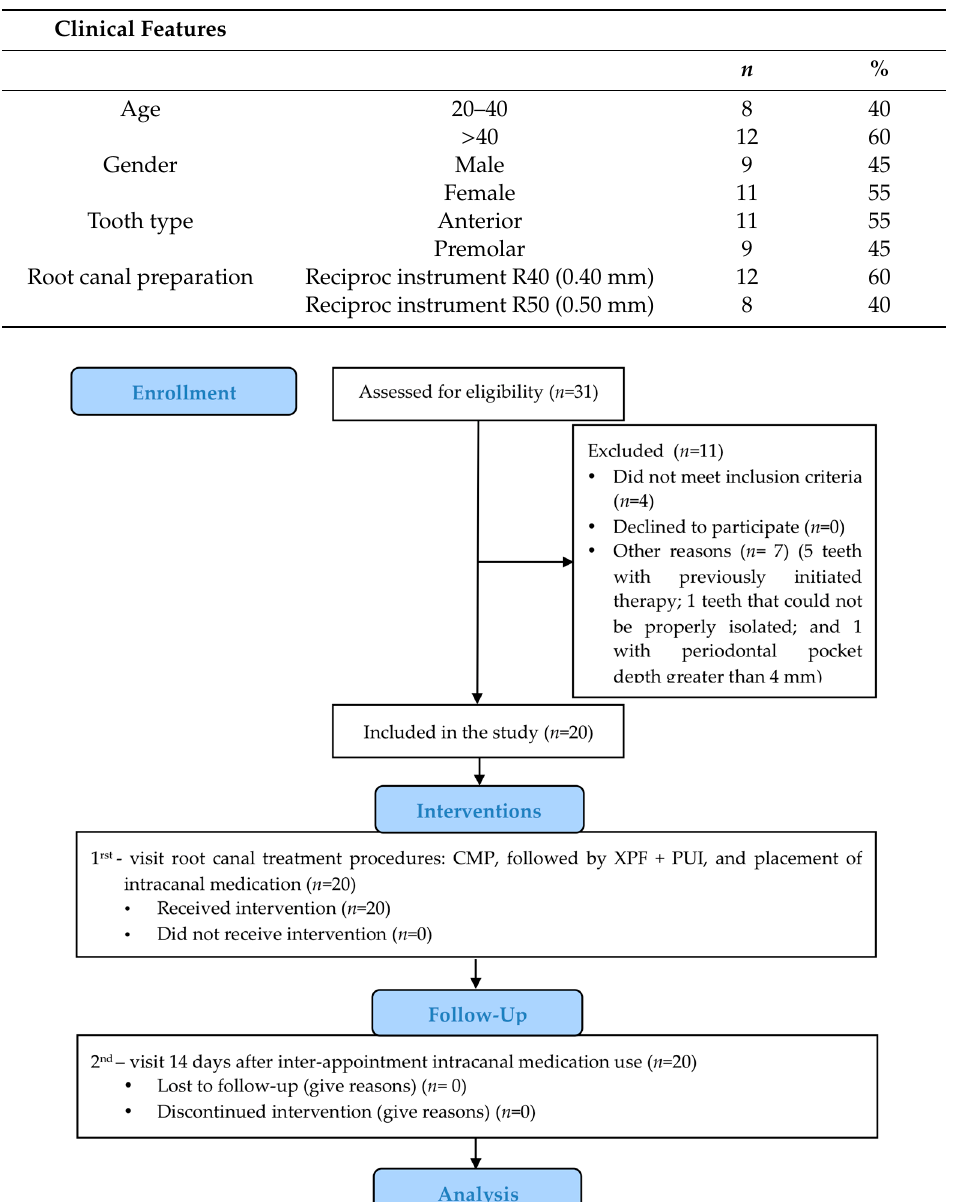
Table 1. Clinical characteristics of the 20 cases included in this study.